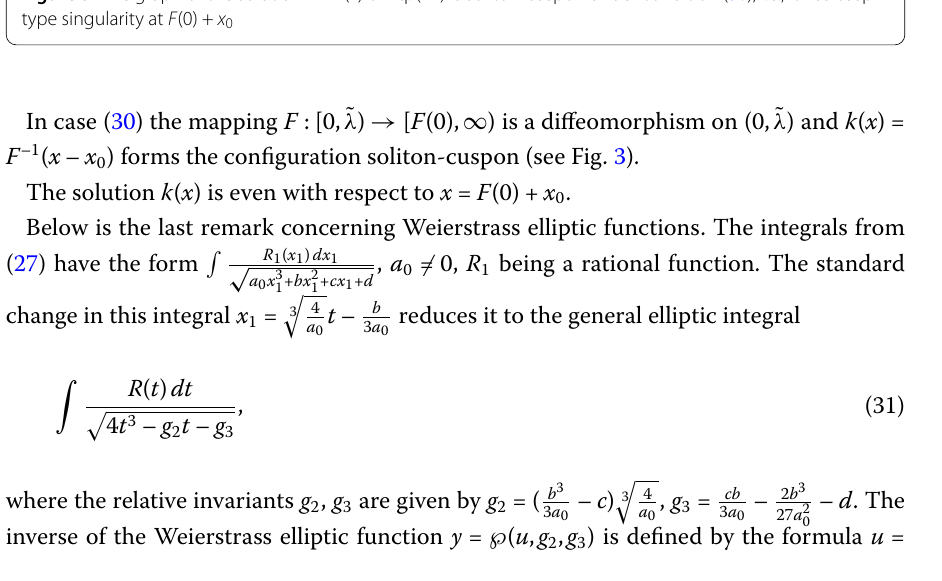
Figure 3 The graph of the solution k = k ( x ) of Eq. (24) is soliton-cuspon under condition (30), i.e., it has cusp type singularity at F (0) + x